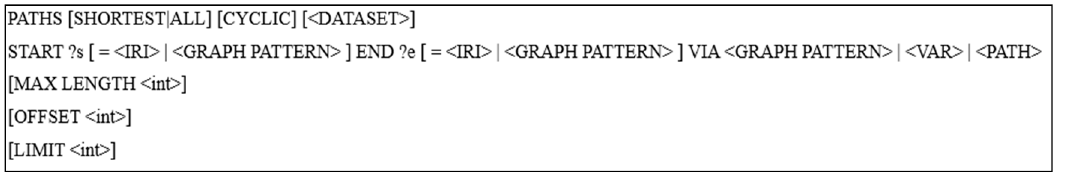
Figure 2. The path query syntax provided in the Stardog RDF database.